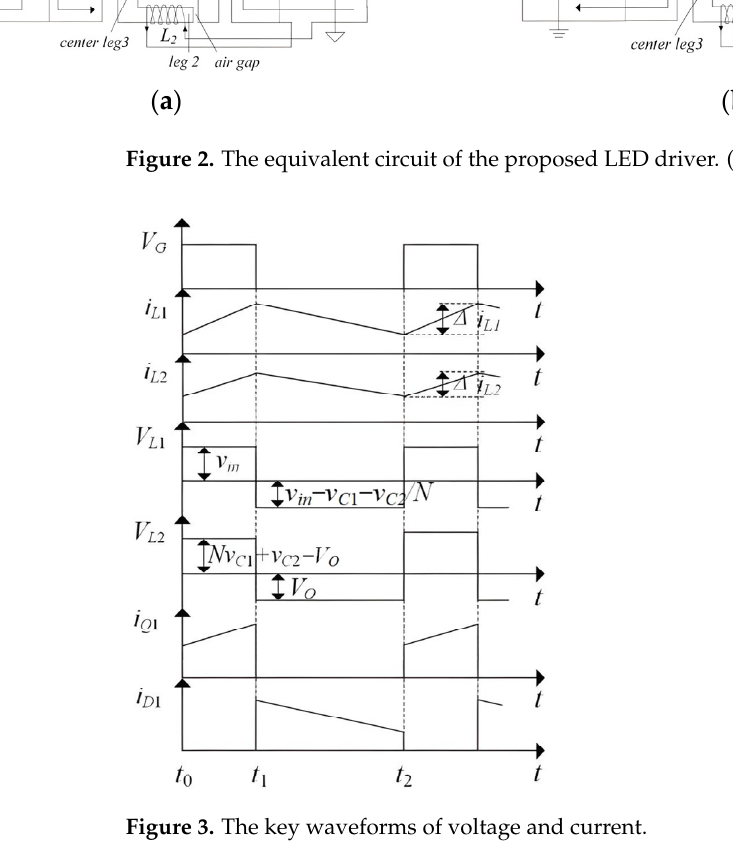
Figure 3. The key waveforms of voltage and current.